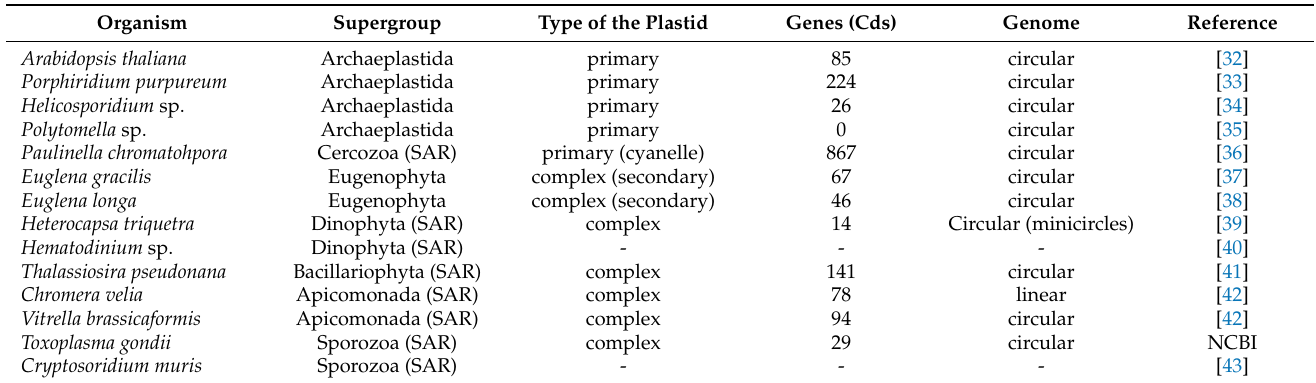
Table 1. Selected plastids and their characteristics in various eukaryotes. It demonstrates the reductive evolution of plastids in